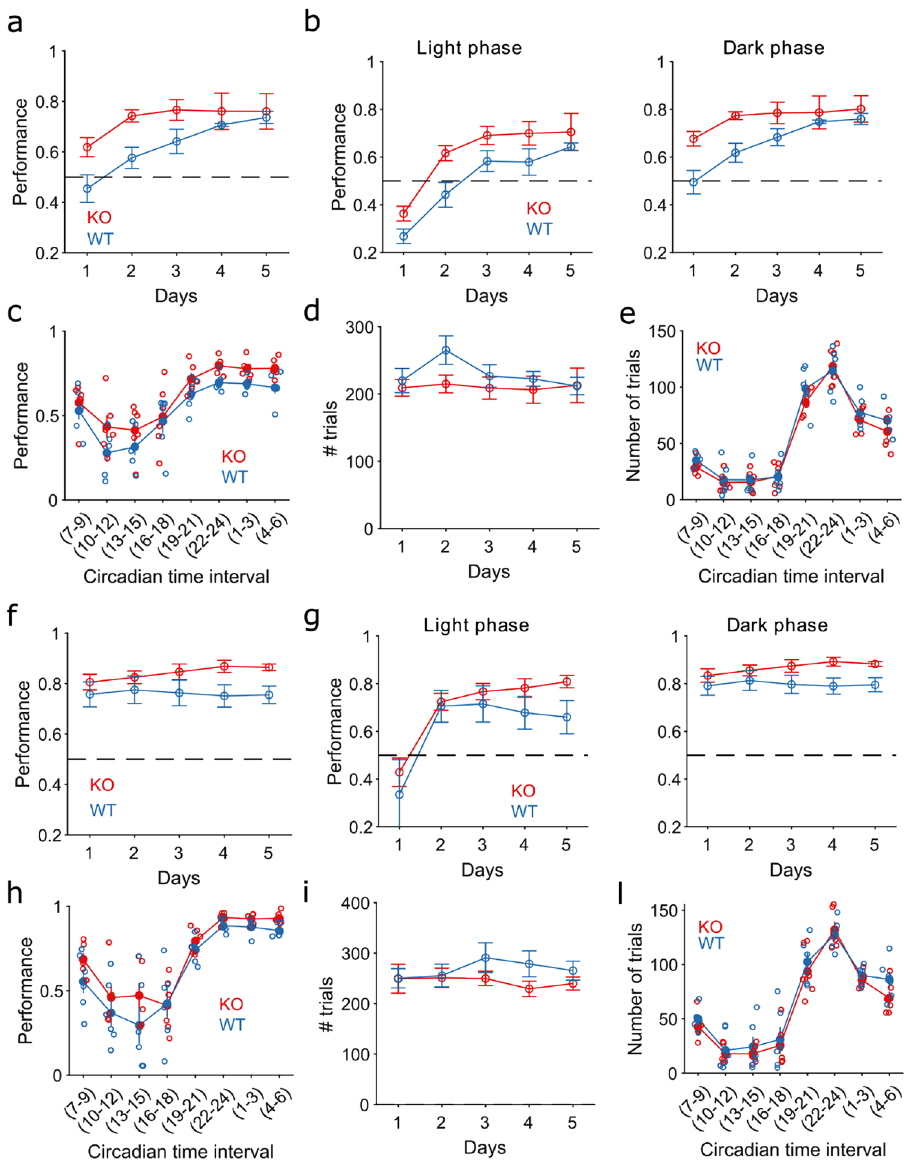
Figure 1. TAAR5 KO mice performance is higher than WT. ( a-e ). week 1. f-l. week 2. ( a ). Performance over days for KO mice (red) and WT (blue). Performance is the ratio of correct trials over the total number of trials per day. Correct trials include rewarded and probe trials. (2-way Anova, effect of time p < 0.005, F = 6.78, effect of group p < 0.005, F = 13.23). Every panel shows mean ± SEM b. Performance per day during the light (left panel) and dark (right panel) phases. Curves show mean ± SEM (2-way Anova, light phase: effect of time p < 0.005, F = 20.71, effect of group p < 0.005, F = 15.08; dark phase: effect of time p < 0.005, F7.22, effect of group p < 0.005, F = 16.01). ( c ). Performance along the circadian cycle grouped by intervals of 3 h. Each empty circle is a subject (2-way Anova, effect of time p < 0.005, F = 23.87, effect of group p < 0.005, F = 14.54) ( d ). Number of trials over days of training (2-way Anova, non significant effect of time p = 0.4, F = 0.88, no effect of group p = 0.09, F = 2.94). ( e ). Total number of trials per hour along the circadian cycle grouped by intervals of 3 h. (2-way Anova, effect of time p < 0.005, F = 103.26, no effect of group p = 0.1, F = 2.69). ( f ). Similar to panel a for week 2. (2-way Anova, no effect of time p = 0.9, F = 0.19, effect of group p < 0.005, F = 11.54). ( g ). Similar to panel b for week 2. (2-way Anova, light phase: effect of time p < 0.005, F = 9.83, no effect of group p = 0.06, F = 3.5; dark phase no effect of time p = 0.8, F = 0.29, effect of group p < 0.005, F = 13.7). ( h ). Similar to panel c for